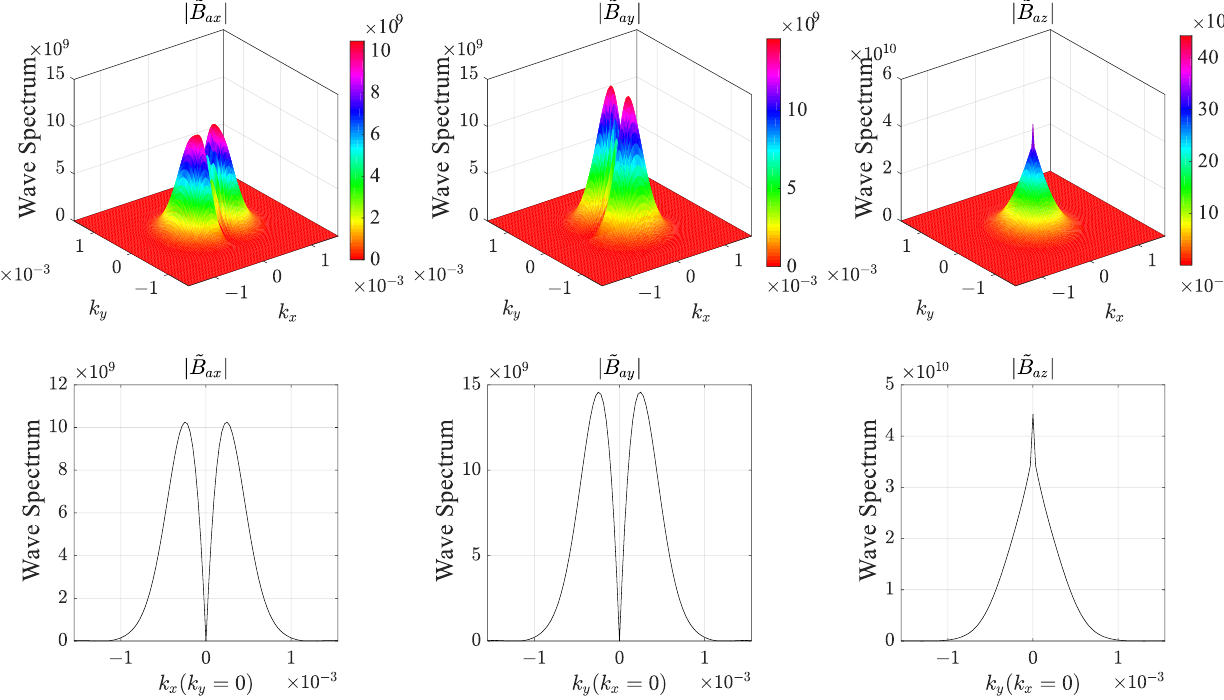
Figure 8. Magnetic field spectrum distribution in wavenumber domain (z = 3 km).